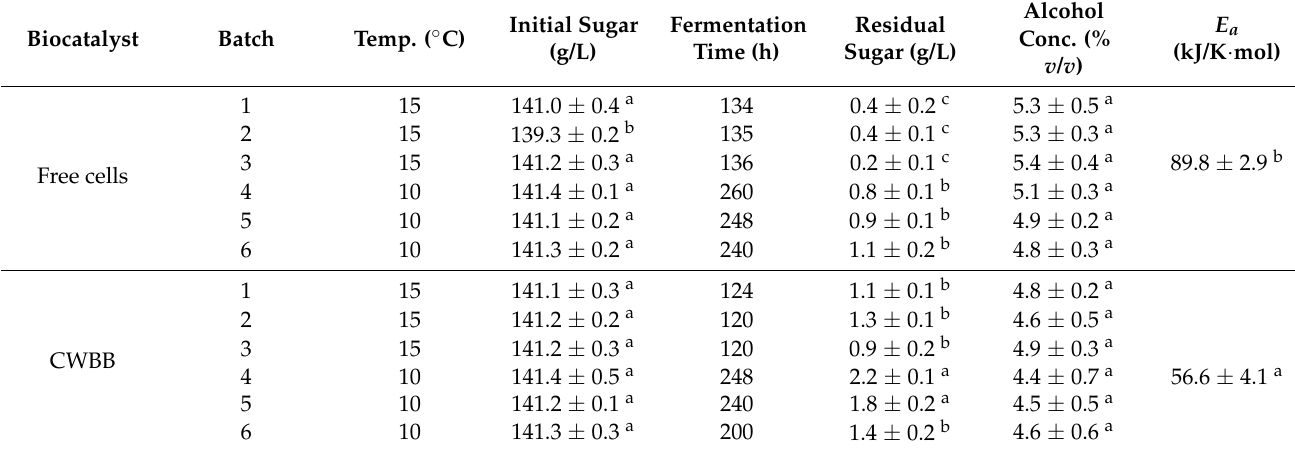
Table 1. Process parameters of the fermentation of wort by free cells and the Citrus Waste Brewing Biocatalyst (CWBB).